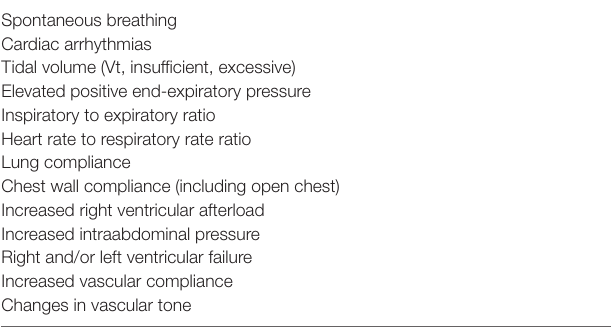
tAbLe 3 | Factors potentially interfering with PPV and SVV. a